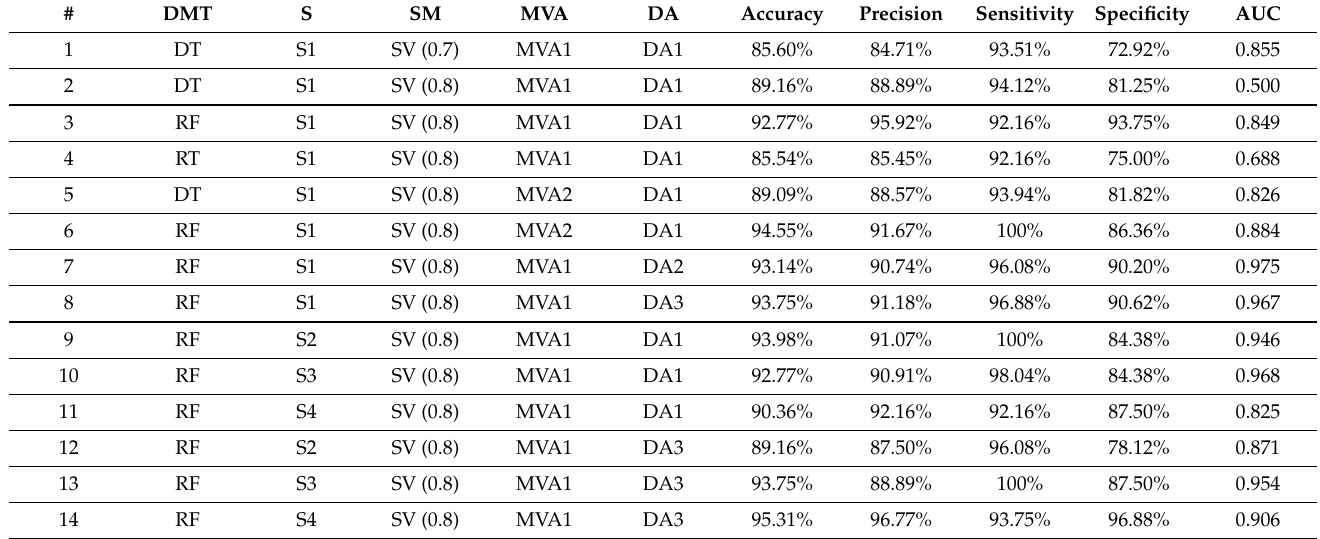
Table 2. Best results obtained regarding Accuracy, Precision, Sensitivity, Specificity, and AUC